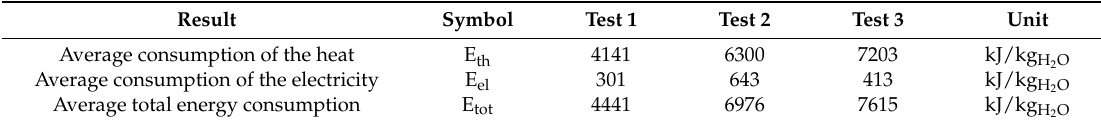
Table 3. Energy consumed by the paddle dryer for the drying process for each of the